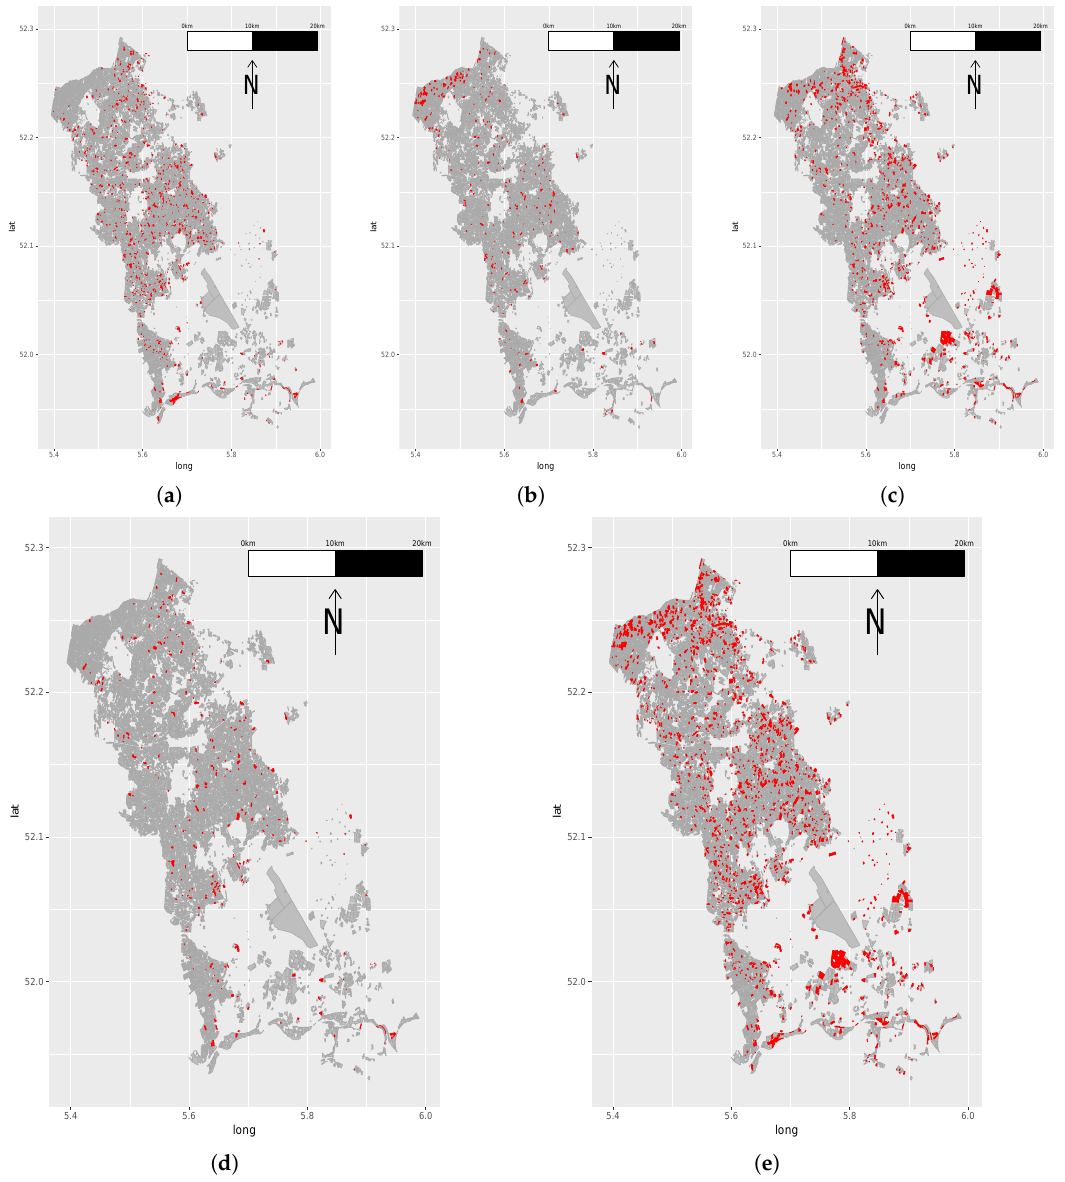
Figure 7. Maps showing the distribution of the non-marked (grey) and marked (red) declared grasslands with the different marker combinations: ( a ) S1 backscatter, ( b ) S1 coherence, ( c ) S2 BSI, ( d ) S1 AND S2 and ( e ) S1 OR